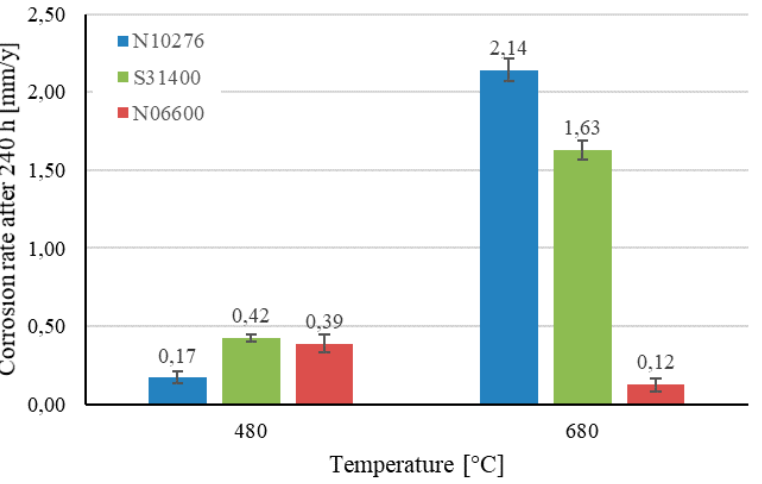
Figure 3. Corrosion rates vs. temperature of the tested alloys after corrosion experiments at 480 °C and 680 °C.